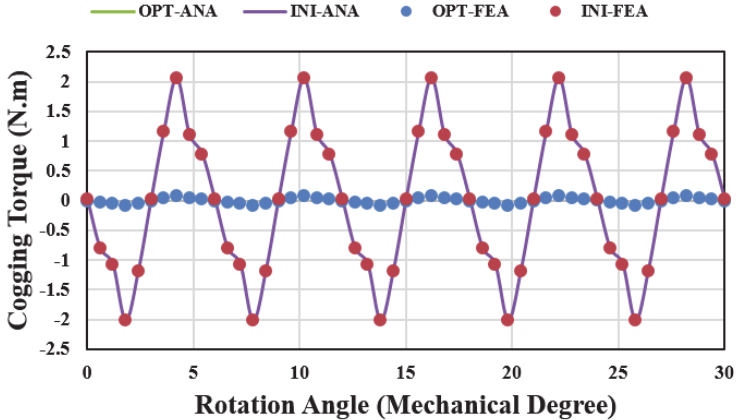
Figure 6. An open circuit analytical and numerical comparison of the cogging